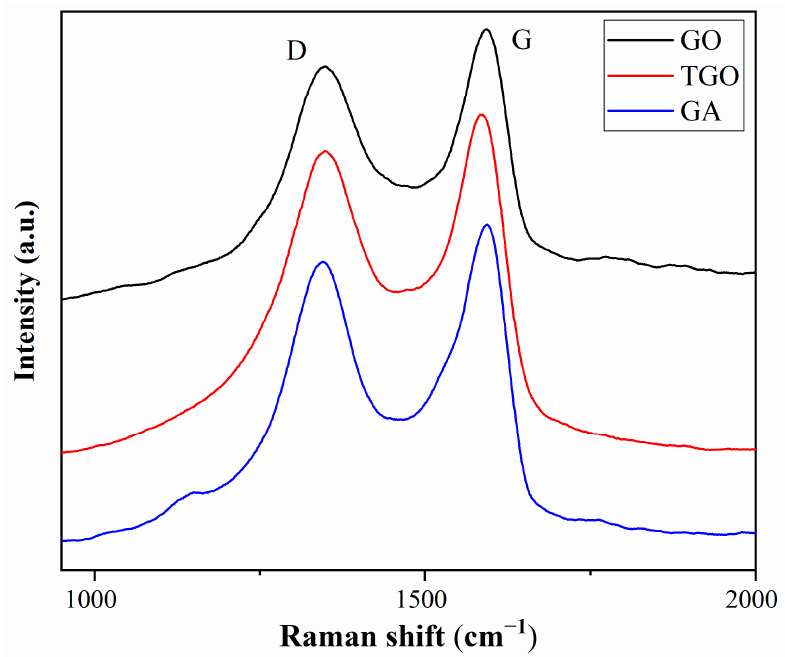
Figure 3. Raman spectra of GO, TGO and GA.